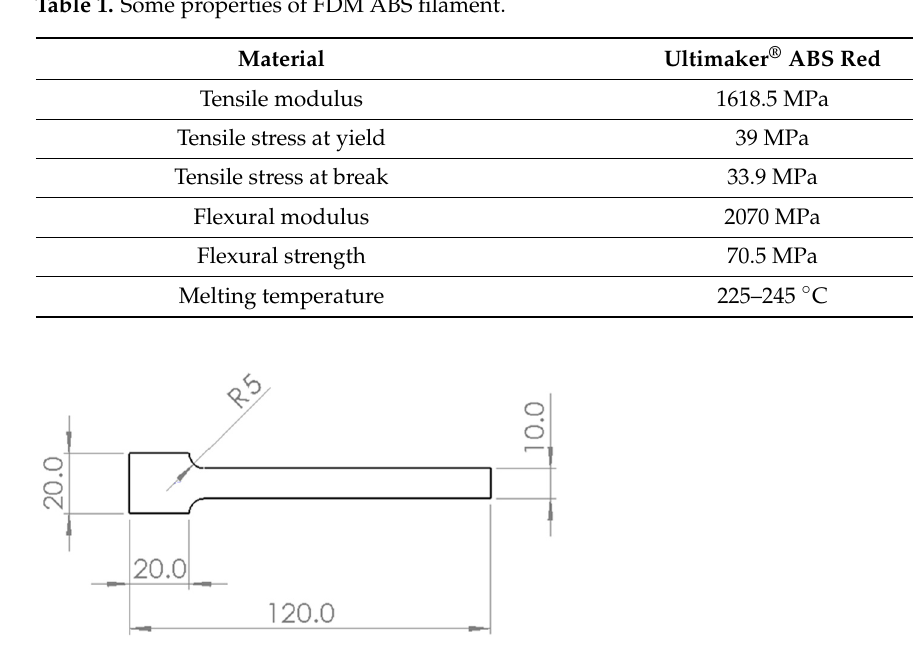
Figure 1. Geometrical dimension of samples (unit: mm).